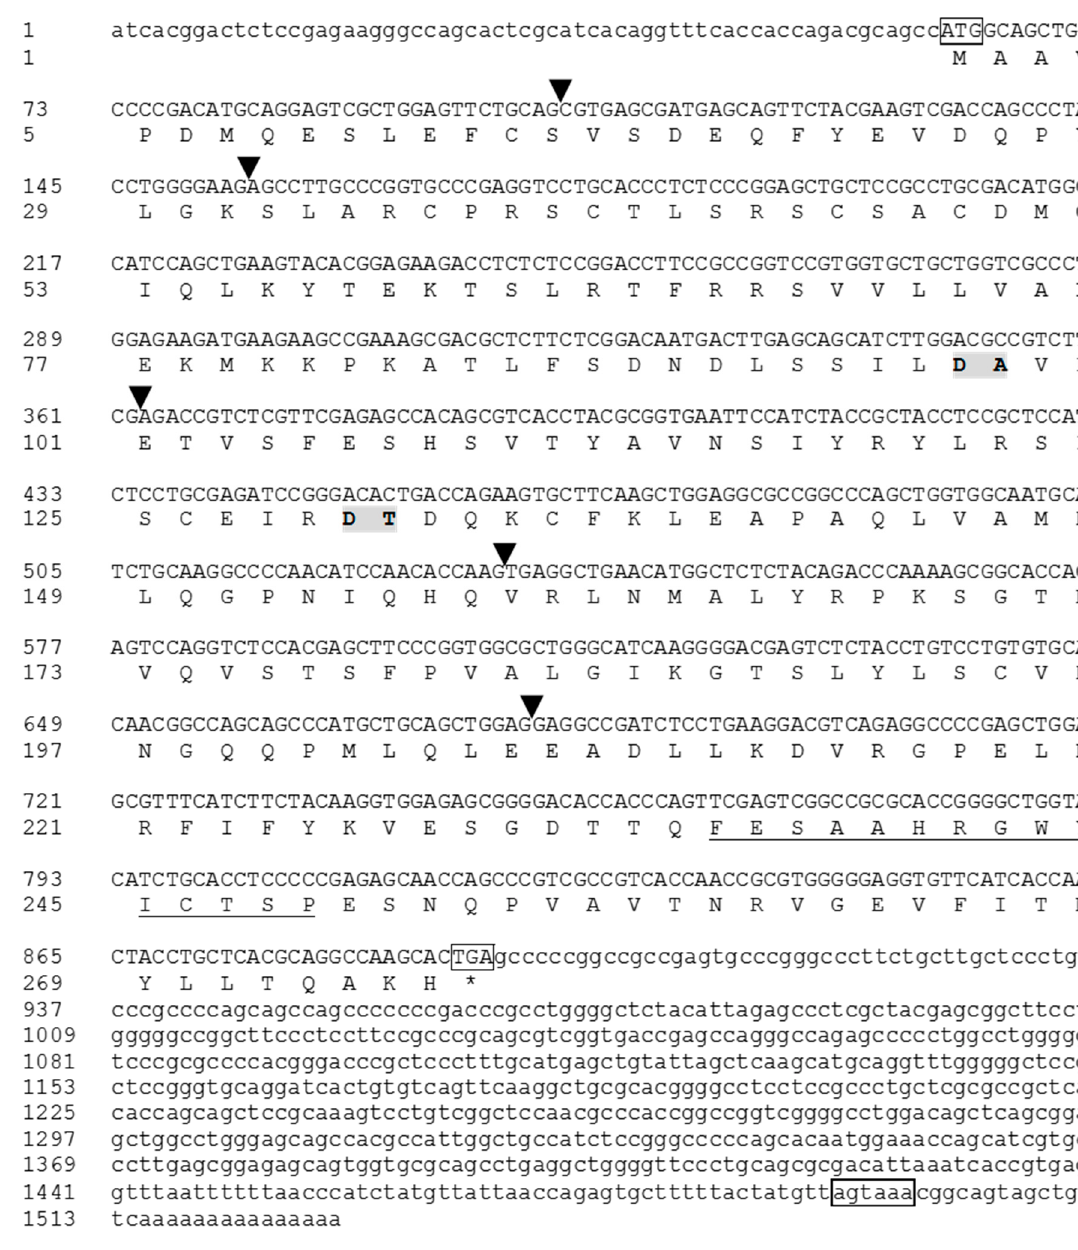
Figure 1. Nucleotide and amino acid sequence of P. sinensis IL ‐ 1 β . The start and stop codons and polyadenylation signal (AGTAAA) in the 3 ʹ‐ UTR are boxed. The IL ‐ 1 family signature is underlined. Predicted IL ‐ 1 ‐ converting enzyme cut site is highlighted in grey. The intron position is indicated with a triangle.